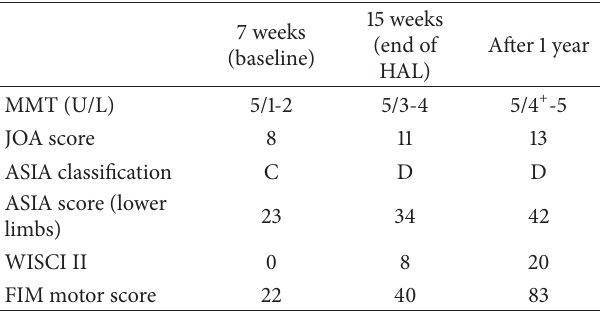
Table 1: Baseline and clinical assessment during follow-up